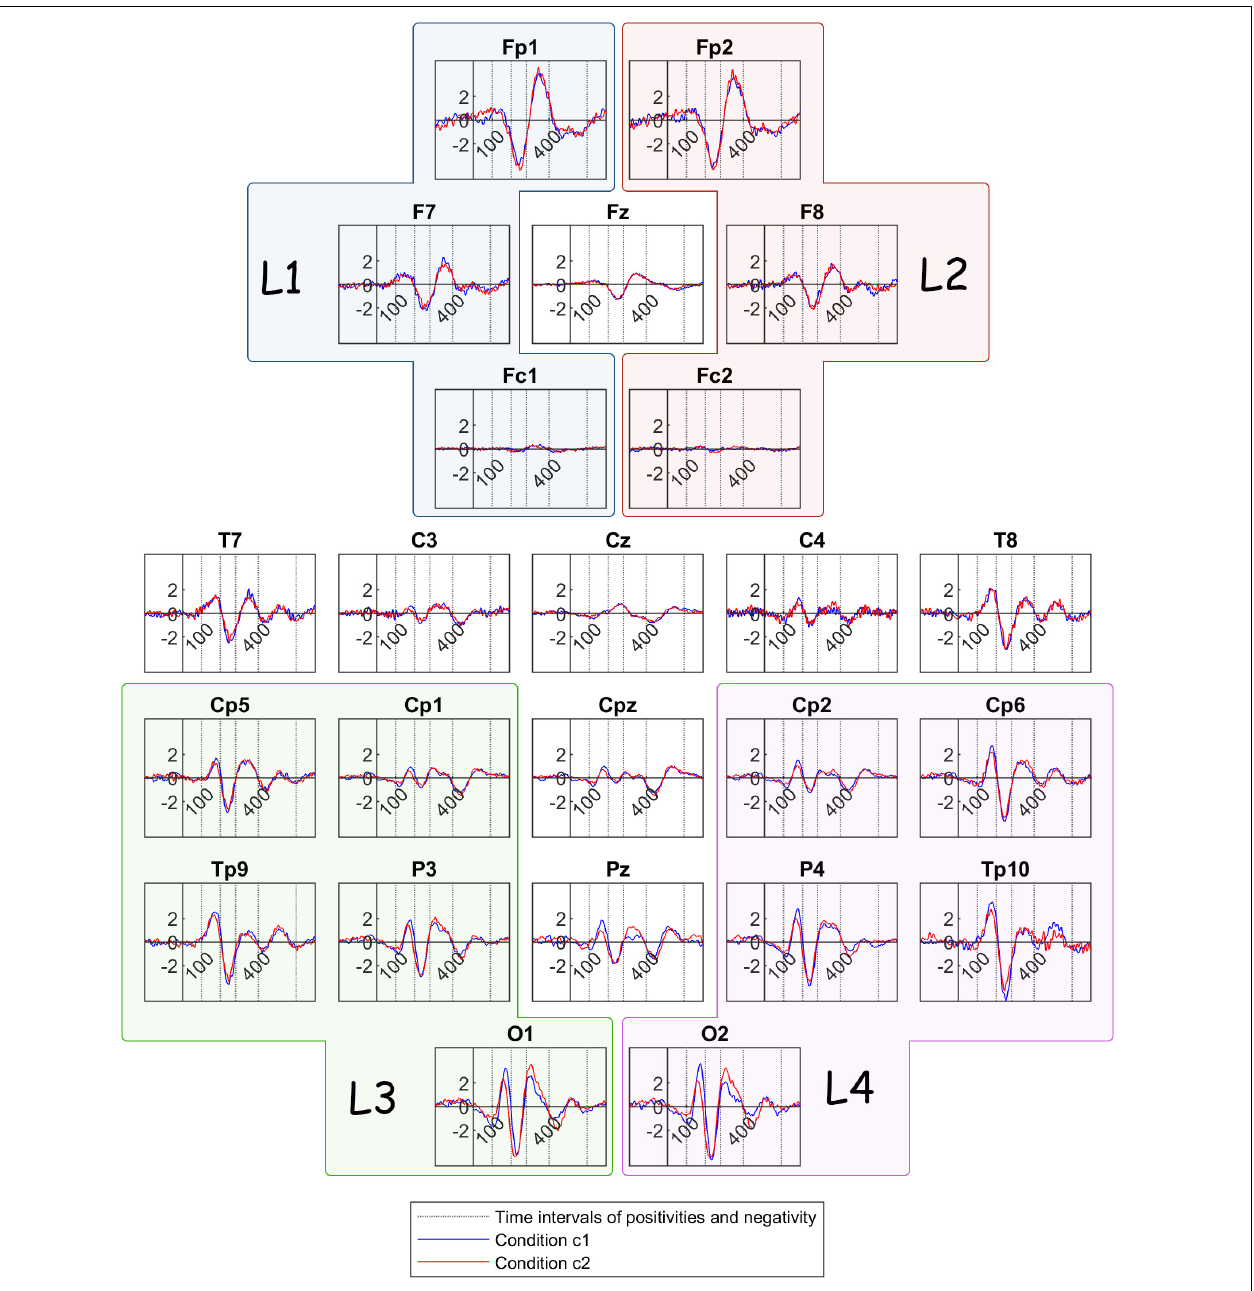
FIGURE 4 | Grand mean ERP traces across all participants, for condition c1(bistable condition – blue line) and condition c2 (unambiguous condition – red line). The dotted lines show the limits of the time intervals for the features of the current study: 100, 200, 280, 400, 600 ms. L1, L2, L3, and L4 are the group channels for the